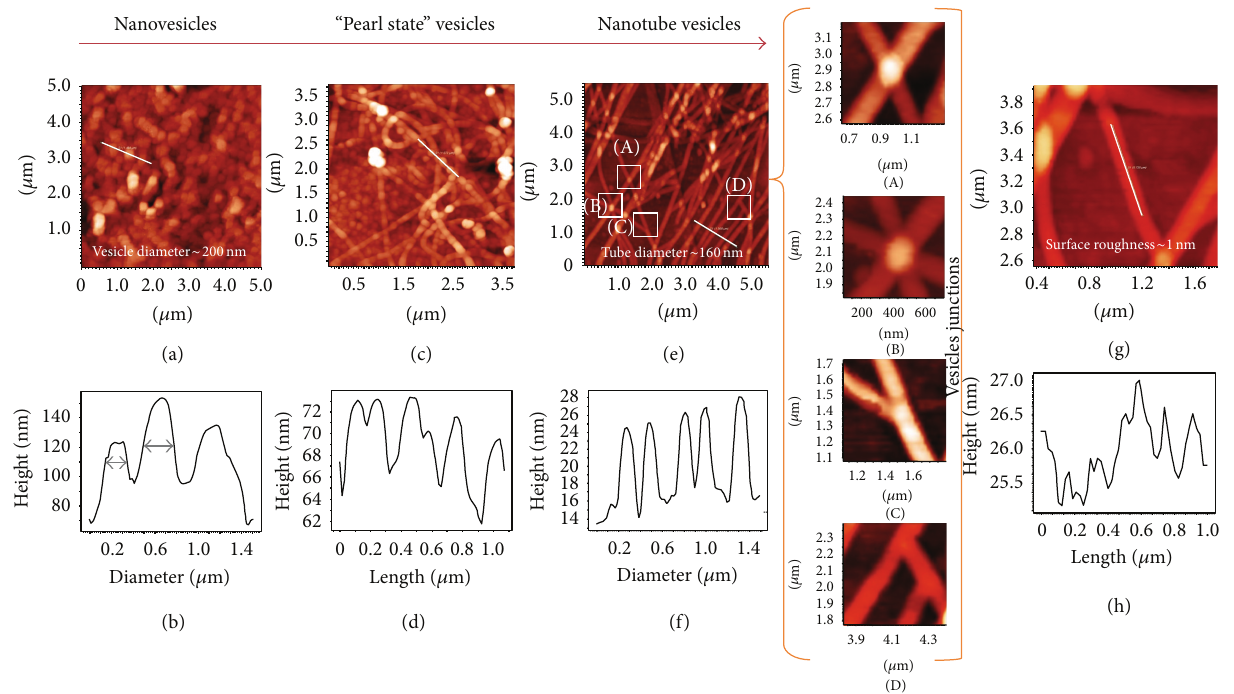
Figure 6: AFM mechanistic analysis of the formation of nanotubes from nanovesicles: (a) randomly distributed vesicles, (c) fusion of vesicles to form pearl-chain like structures, (e) nanotubes, and (g) roughness of a tube. The corresponding profile analyses are shown in (b), (d), (f), and (h),